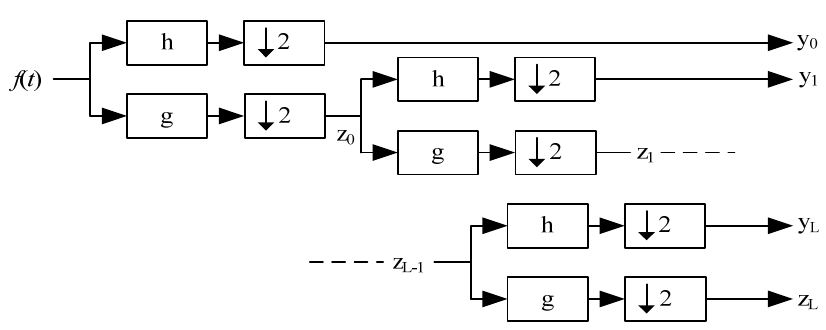
Figure 1. Multi-resolution analysis using